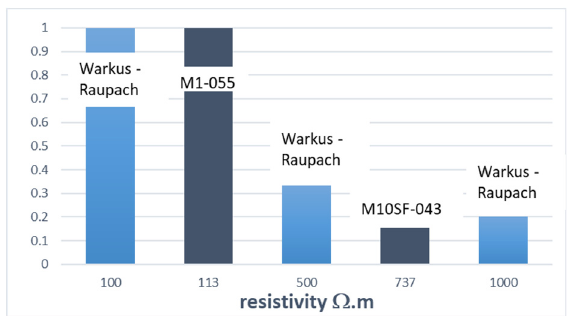
Figure 12. Influence of the resistivity at the cathode on the “galvanic” corrosion current.